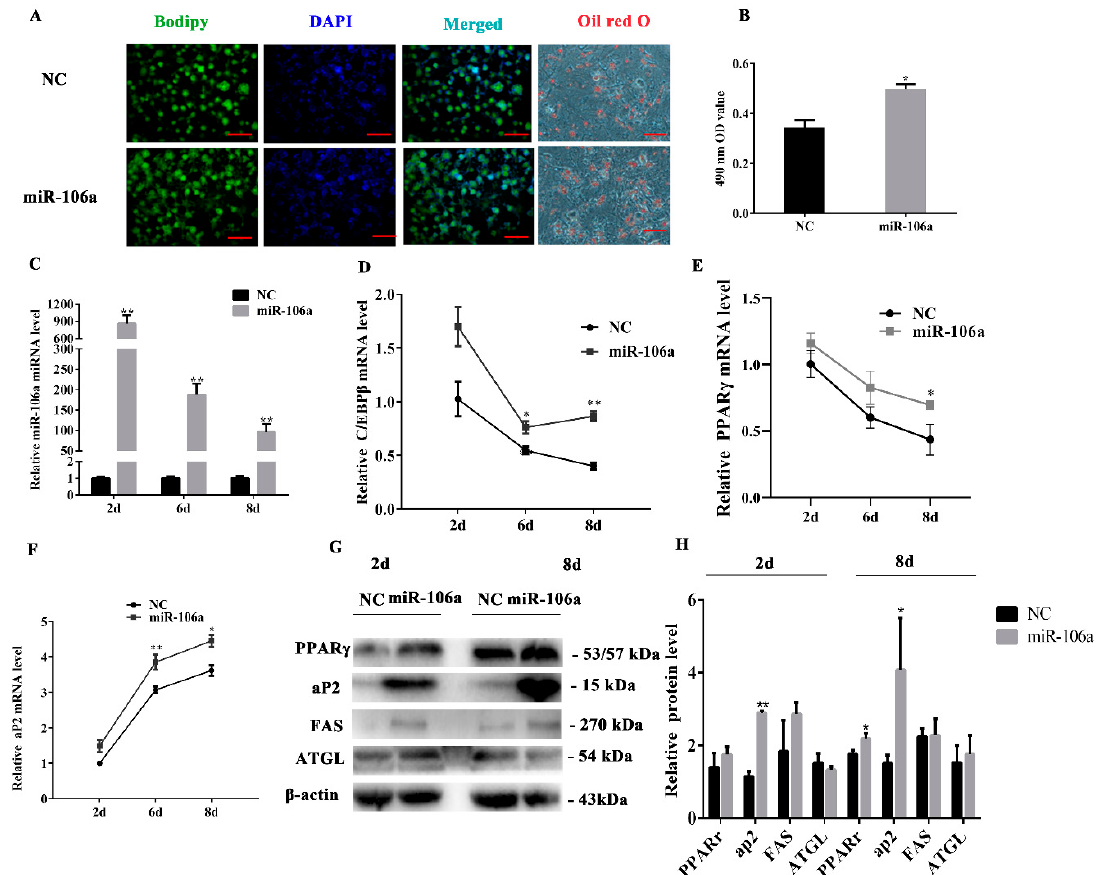
Figure 4. The overexpression of miR-106a accelerates porcine preadipocyte differentiation. The miR-106a agomir or NC were transfected into cells at 80% density at 50 nmol/L; (A) boron dipyrromethene (BODIPY) staining was performed in cells on the 8th day of differentiation, the lipid droplets were stained with BODIPY (green) and the cell nucleus was stained with DAPI (blue). Oil Red O staining was performed at day 6 after adipogenic differentiation; (B) triglycerides content was measured by spectrophotometric analysis at 490 nm; (C) the overexpression efficiency of miR-106a after transfection with the miR-106a agomir; (D–F) real-time qPCR (RT-Qpcr) was used to detect adipogenesis genes, CCAAT/enhancer-binding protein β (C/EBP β ), peroxisome proliferator- activated receptor γ (PPAR γ ), and fatty acid binding proteins (aP2) on the 2nd day, 6th day, and 8th day after adipogenic induction; (G) western blot analysis of the adipogenic genes’ protein expression on the 2nd day and 8th day after adipogenic induction; (H) the quantification of adipogenic genes protein expression levels. Data are representative of the mean ± SEM of three independent experiments. Scale bar: 100 μ m; * p < 0.05, ** p < 0.01.